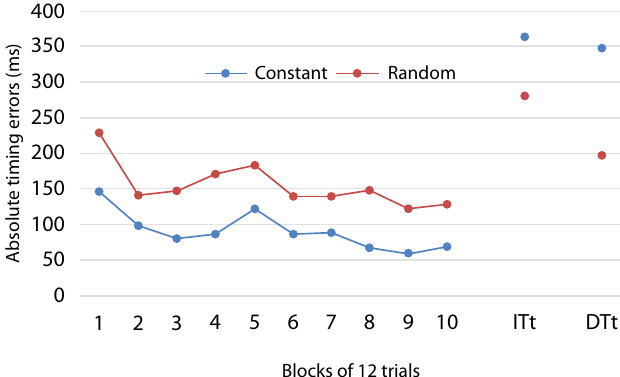
Figure 6 . Adaptation rates and regression slopes in relative and absolute timing measures in both immediate (ITt) and delayed transfer